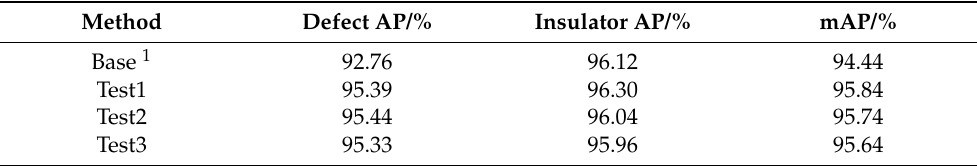
Table 2. Detection AP of the models trained with different regression angles at AP50.